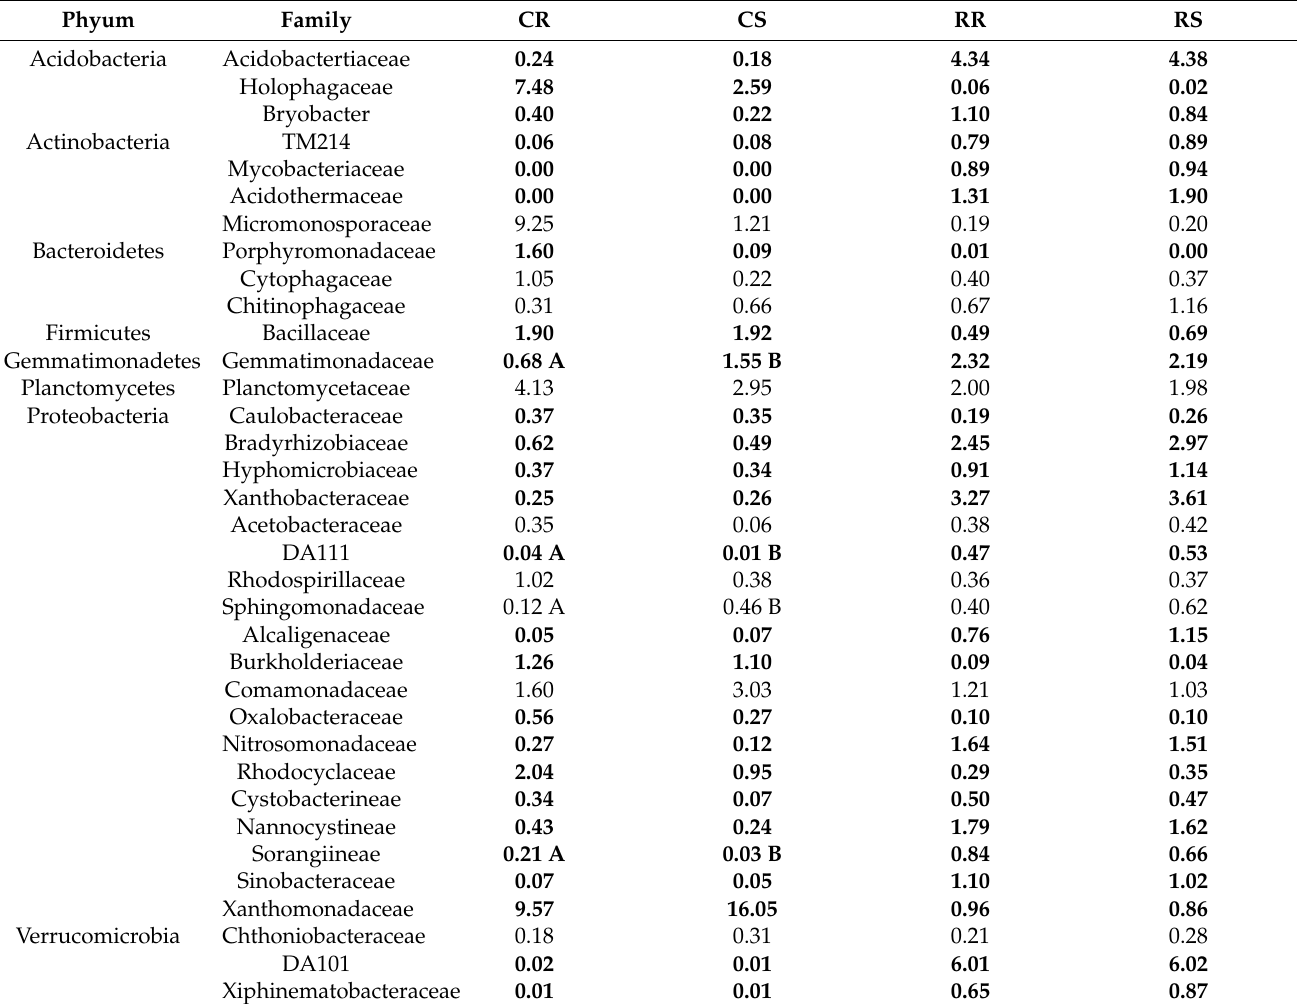
Table 4. Relative abundance (%) of 35 most abundant bacterial families in Agrostis stolonifera micro- cosms (16S rRNA gene fragment amplicon libraries) from static hyphosphere cores (CS), rotating hyphosphere cores (CR), rhizosphere roots from microcosms with static cores (RS) and rhizosphere roots from microcosms with rotating cores (RR); bold numbers indicate significant differences be- tween cores and rhizosphere (C, R). Letters A–B indicate significant difference between static and rotating cores (CS, and CR, n ≥